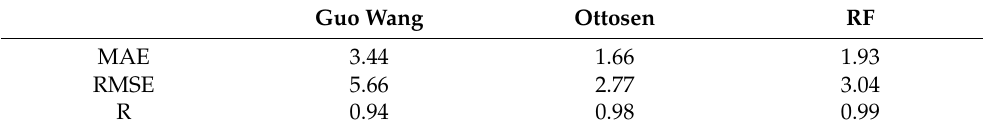
Table 3. Comparison between the neural network strength criterion model and classical strength